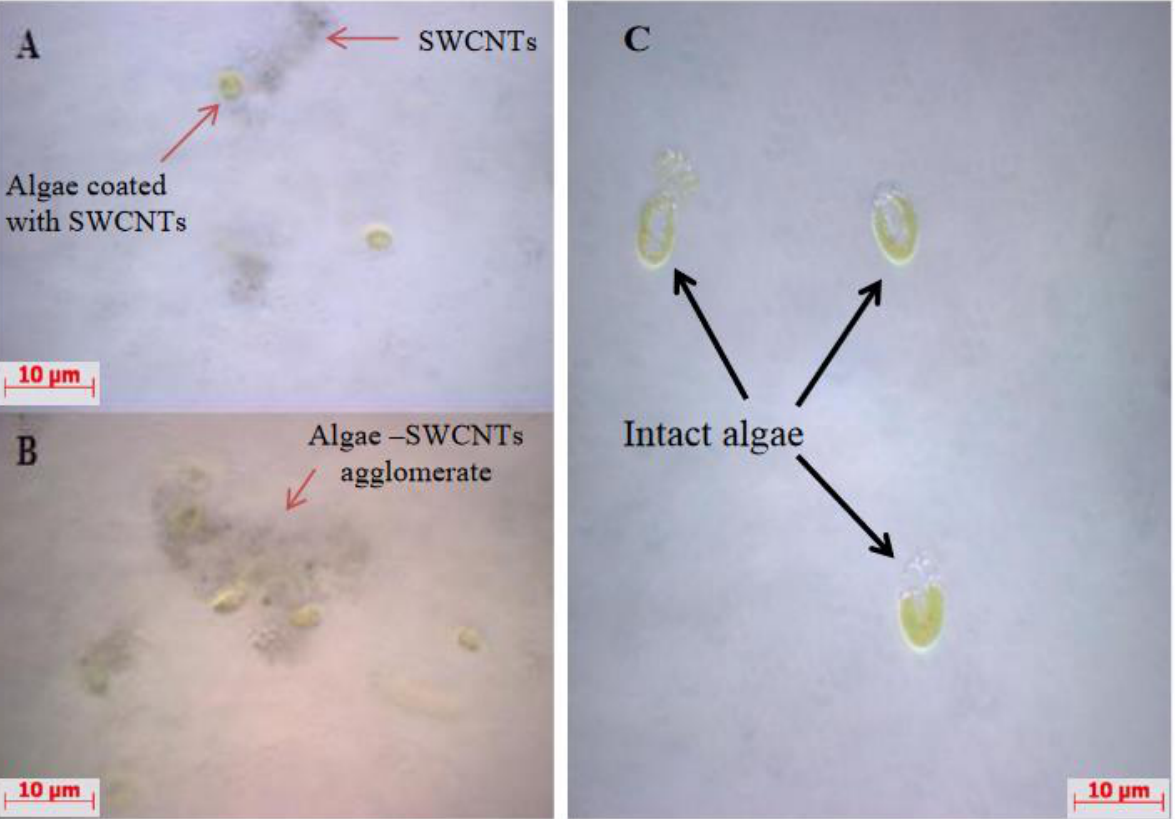
Figure 2. Tetraselmis suecica in the presence and absence of SWCNTs; light micrographs for SWCNT- exposed ( A ) 100 µg L −1 , ( B ) 500 µg L −1 , and Control ( C ). Images show a dark coloration on the surface of treated algae ( A , B ) compared to the clean surface in the control algae ( C ).